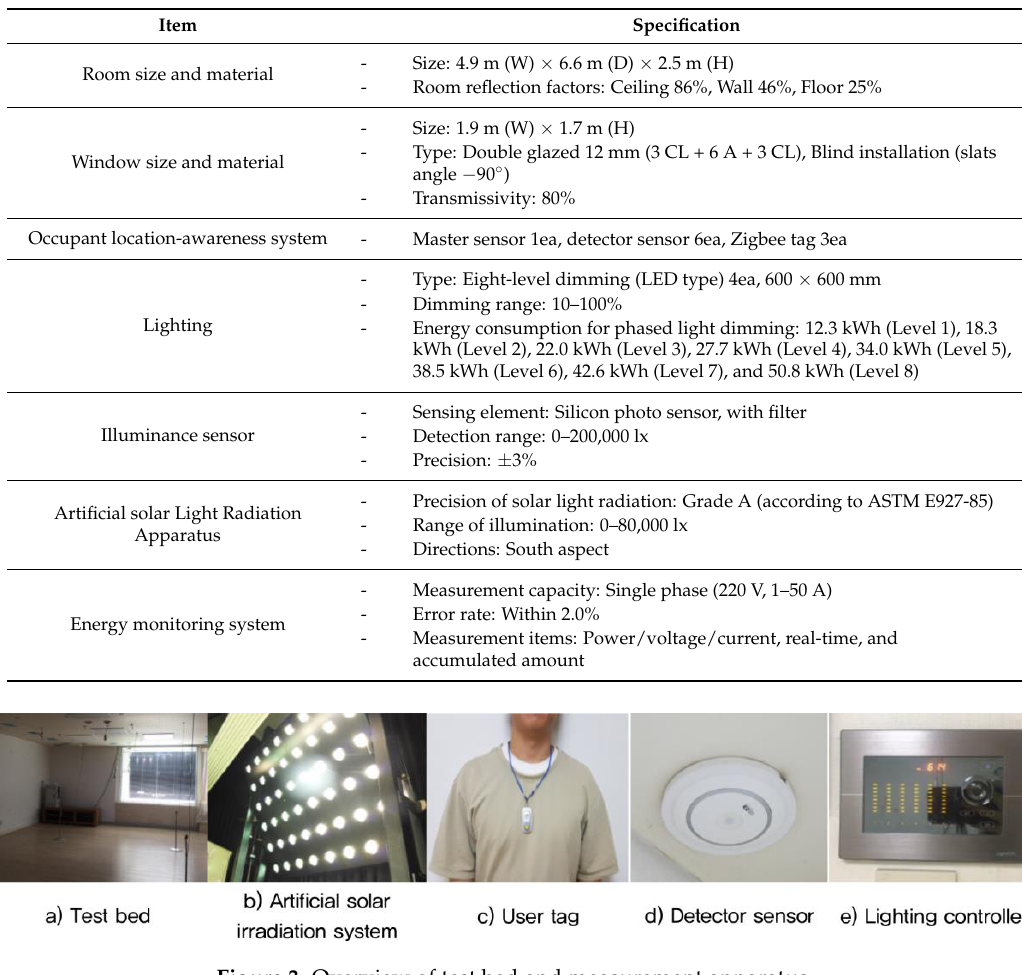
Table 6. Overview of test bed, chamber.